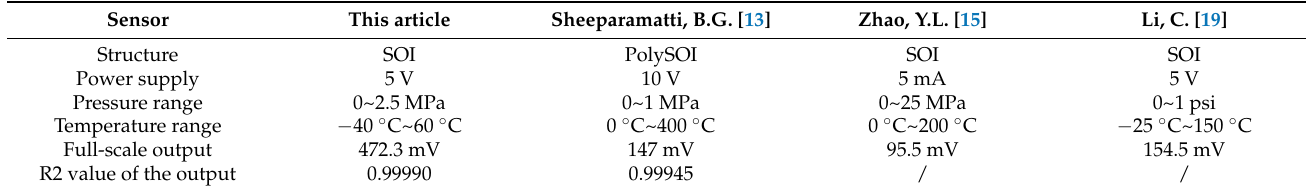
Table 2. Comparison of sensor